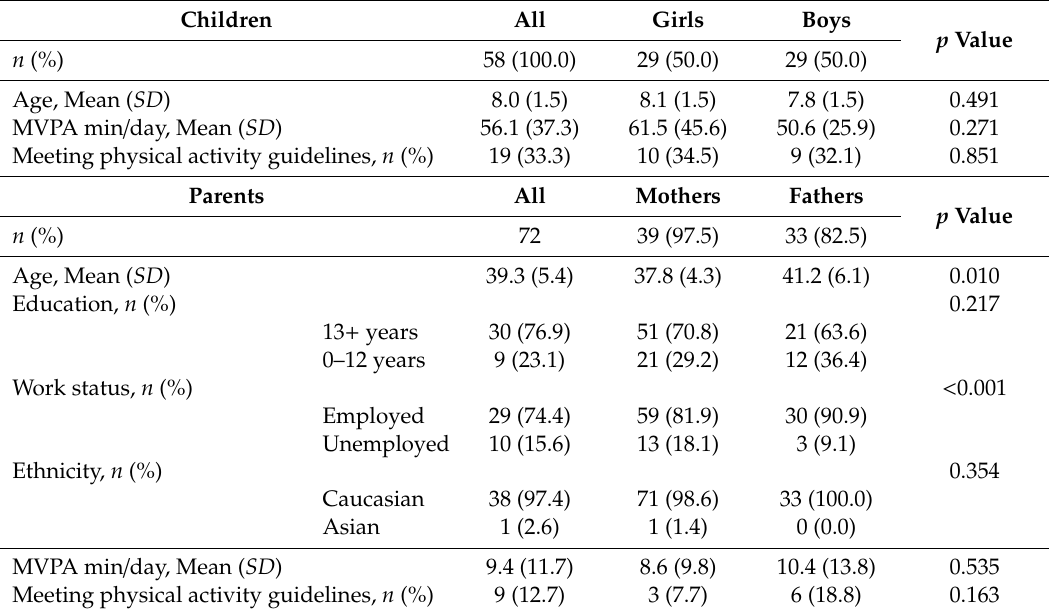
Table 2. Baseline characteristics of Step it Up